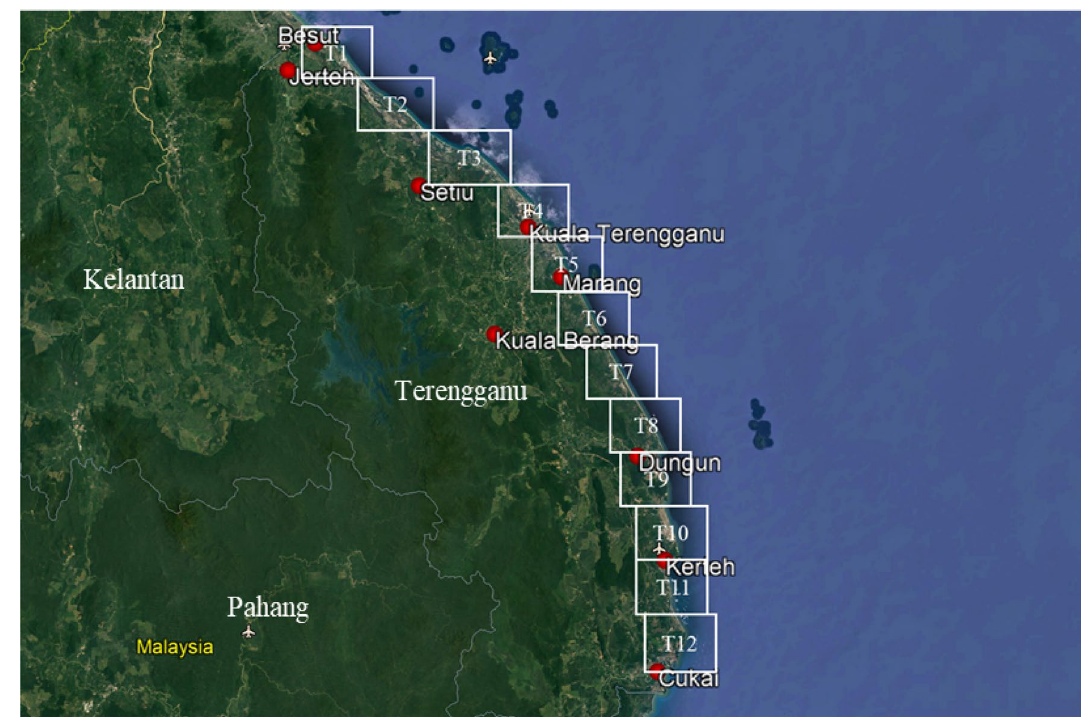
Fig. 7 Parcels (T1–T12) of inundation map in